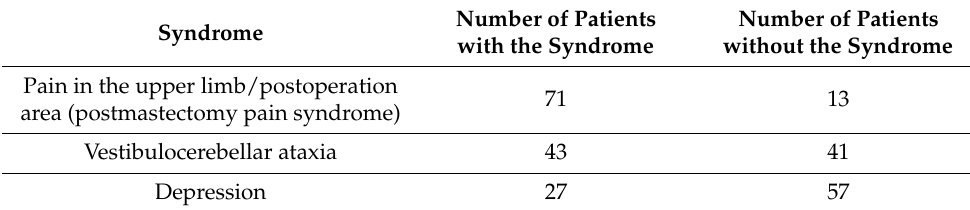
Table 3. The number of patients in groups, depending on the syndromes.